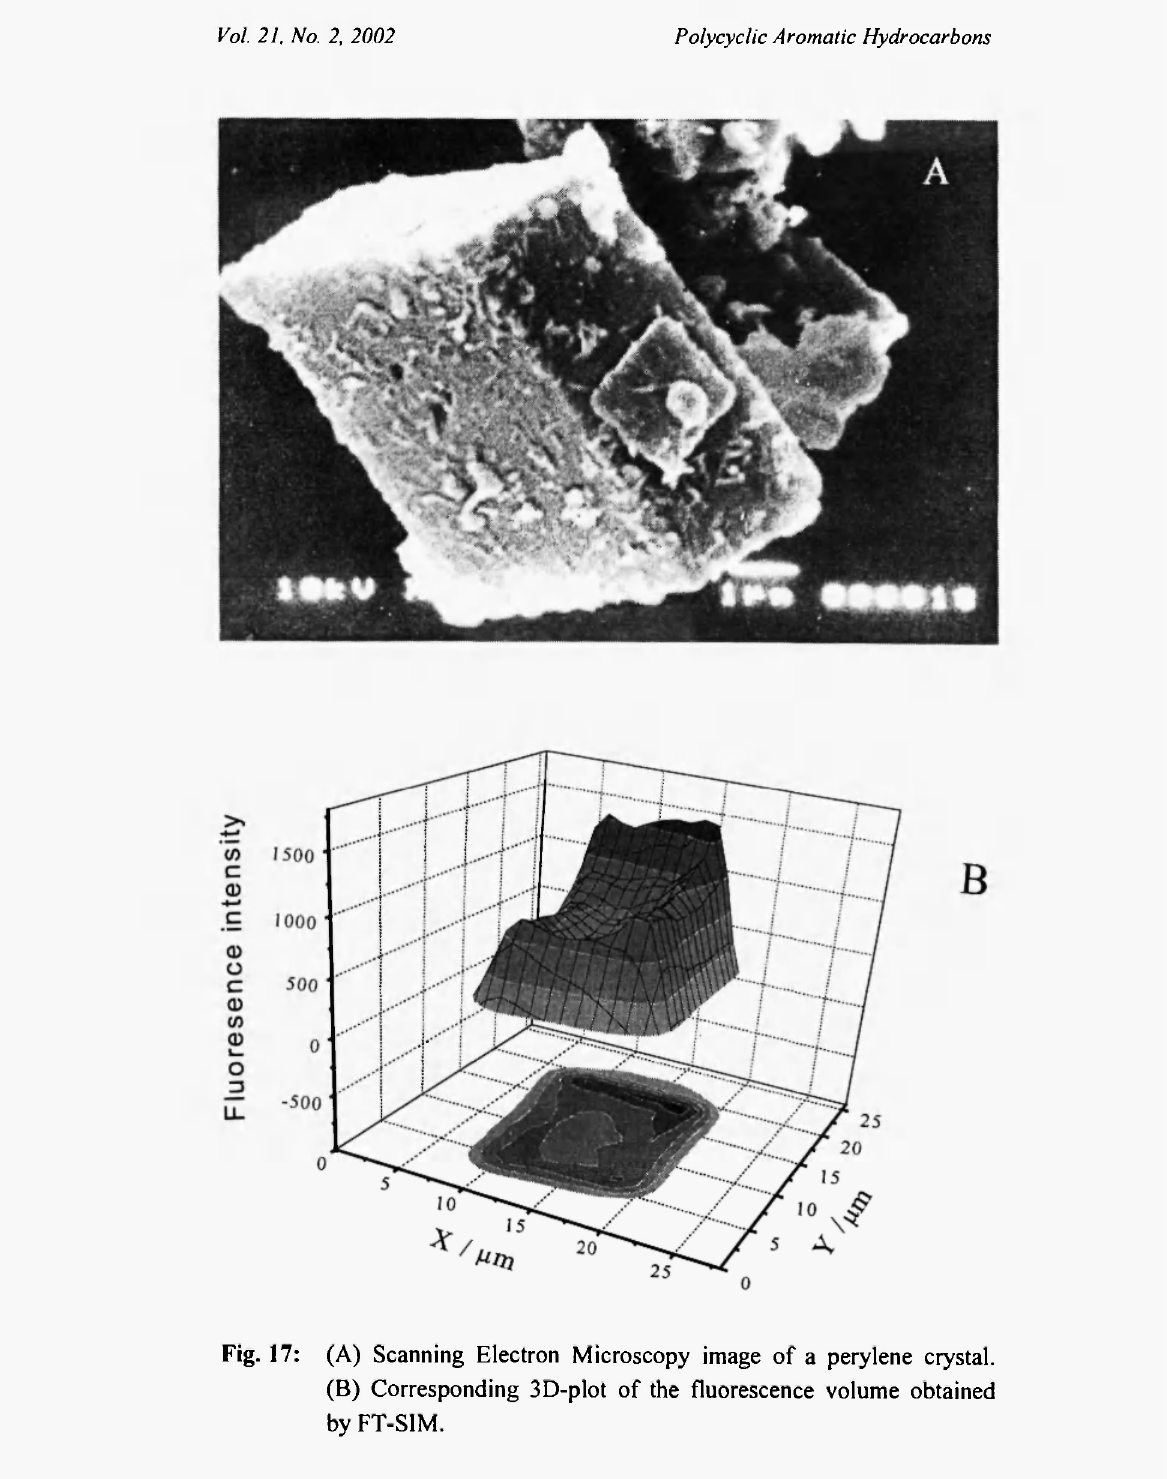
Fig. 17: (A) Scanning Electron Microscopy image of a perylene crystal. (B) Corresponding 3D-plot of the fluorescence volume obtained by